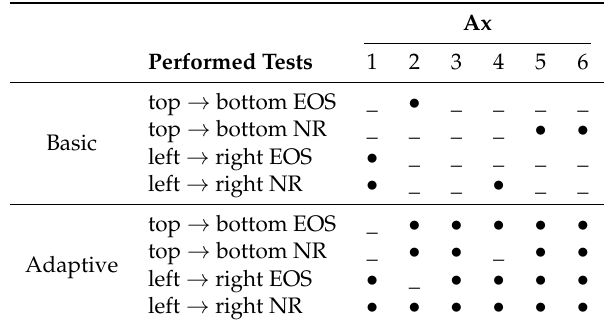
Comparison of the number of axes that are able to detect the collision using the basic collision detection procedure and the proposed virtual sensor, including the learning and adaptive